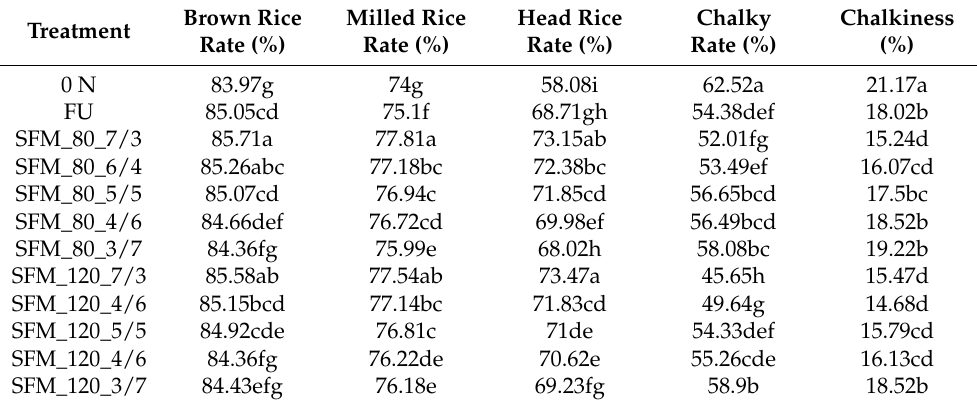
Table 7. Effects of different fertilization modes on rice milling and appearance quality.